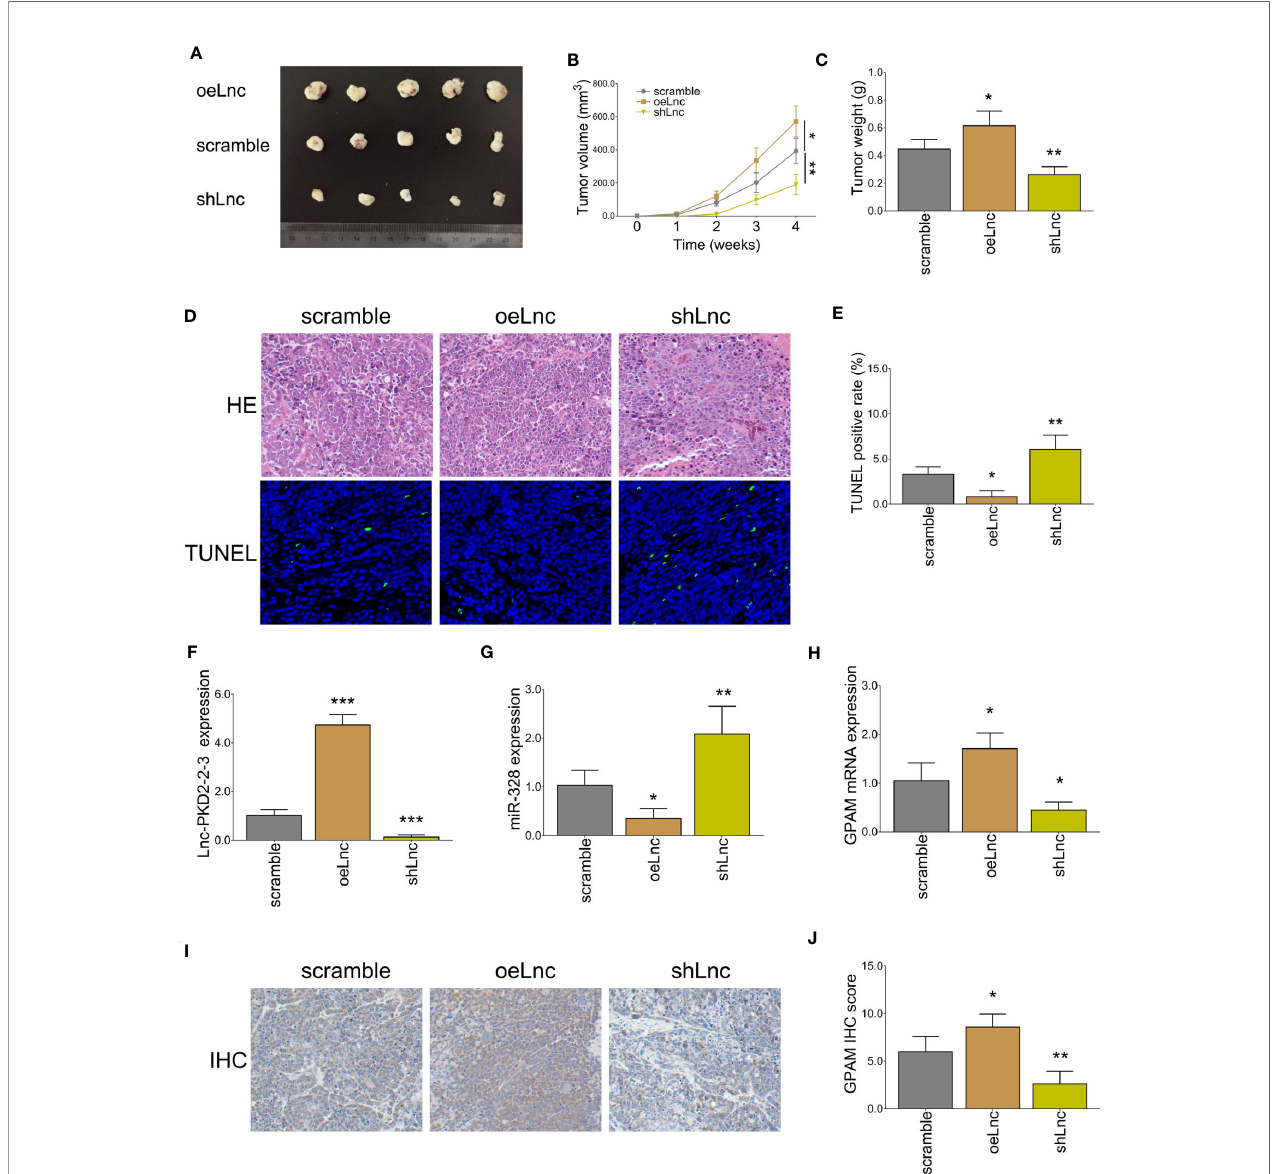
FIGURE 9 | In vivo xenograft mice experiments. Tumor volume images (A) , tumor volume calculation (B) , tumor weight (C) , HE and TUNEL staining examples (D) , tumor apoptosis rate (E) , lnc-PKD2-2-3 expression (F) , miR-328 expression (G) , GPAM mRNA expression (H) , GPAM IHC staining examples (I) , and GPAM IHC score calculation (J) among three groups. * P < 0.05; ** P < 0.01; *** P <